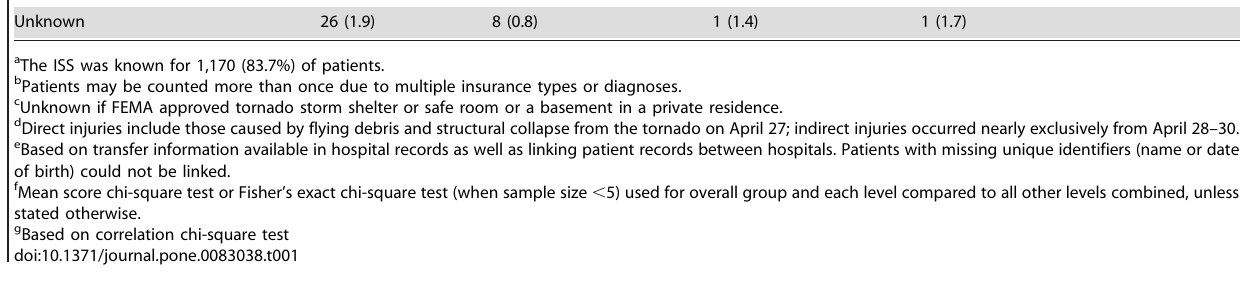
A comparison of census block data with abstracted data